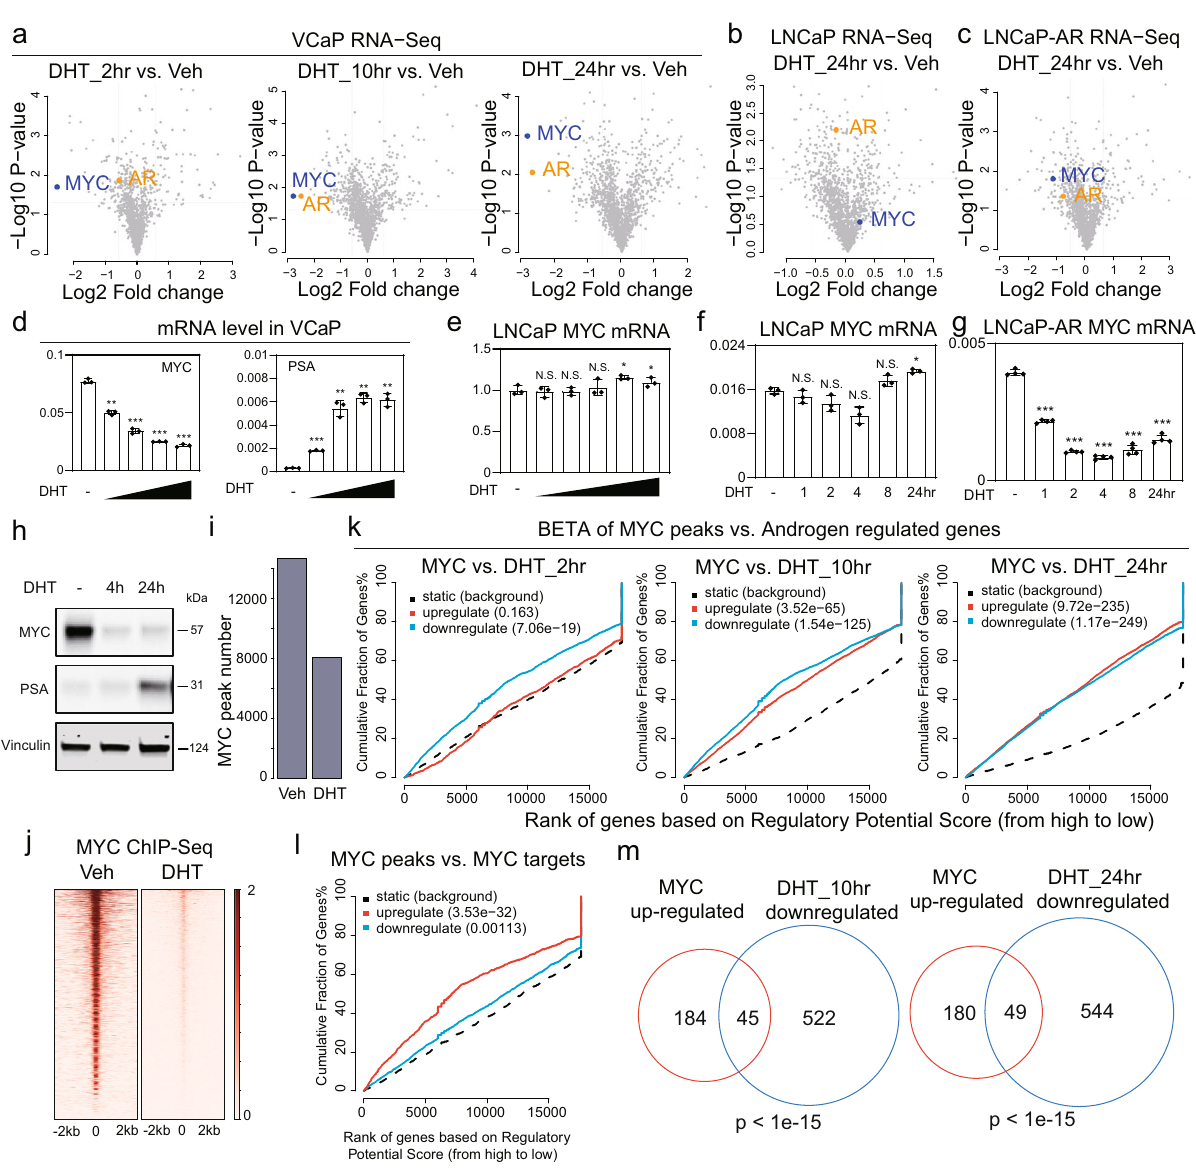
Fig. 2 MYC is a DHT-repressed TF that binds to androgen repressed genes. Volcano plots showing changes of TF genes ( n = 1875) in DHT-treated VCaP cells ( a ), LNCaP cells ( b ), and LNCaP-AR cells ( c ). MYC and AR messages were highlighted. d RT-qPCR for MYC and PSA mRNA (normalized to GAPDH) in DHT-stimulated VCaP cells (10 pM, 100 pM, 1 nM, and 10 nM) for 24 h. e RT-qPCR analysis of MYC mRNA expression (normalized to GAPDH) in LNCaP cells under a range of DHT doses (10 pM, 100 pM, 1 nM, 10 nM, 100 nM) for 24 h treatment. RT-qPCR analysis of MYC mRNA expression (normalized to GAPDH) in LNCaP ( f ) and LNCaP-AR ( g ) cells under 10 nM DHT treatment for indicated times. For d – g , data are presented as mean values ± SD for three biologically independent samples. P values were by two-sided Student ’ s t test. N.S., not signi fi cant; *, P < 0.05; **, P < 0.01; ***, P < 0.001. h Western blotting of MYC and PSA in VCaP cells with 10 nM of DHT for indicated time points. Vinculin is loading control (representative of three independent experiments). i Barplot showing the total peak number of MYC ChIP-seq in VCaP cells grown in androgen depleted medium and then stimulated with vehicle or DHT (10 nM, 4 h); cutoff: q value < 0.05. j Heatmap showing MYC binding signal in VCaP cells without or with DHT (10 nM, 4 h). k BETA to assess the association between MYC binding (under vehicle condition) and androgen-regulated gene expression in VCaP cells. The red line indicates MYC-upregulated genes and the light blue line indicates the MYC-downregulated genes. l BETA to determine the association between MYC binding (under vehicle condition) and MYC-regulated gene expression in VCaP cells. The red line indicates MYC-upregulated genes and the light blue line indicates the MYC-downregulated genes. m Overlap between MYC positively regulated genes (fold change > 2 and P < 0.05) and DHT-repressed genes (fold change < 1/2 and P < 0.05). P values were determined by a hypergeometric test in m . Source data are provided in Histogram and Immunoblot Source Data fi